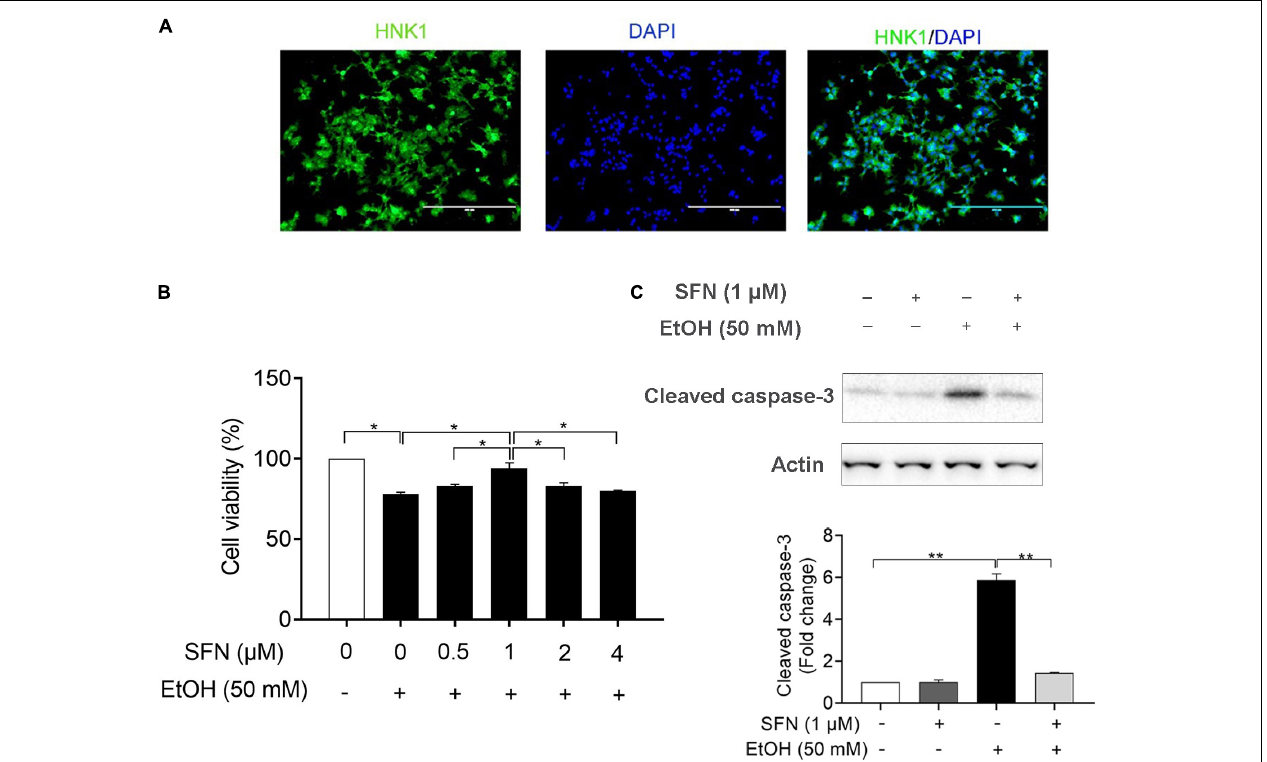
FIGURE 1 | SFN significantly diminished the ethanol-induced apoptosis in hNCCs. (A) Immunocytochemistry of NCC marker, HNK1, in hNCCs differentiated from hESCs. (B) hNCCs were treated with 50 mM ethanol alone or pretreated with SFN at different concentrations for 24 h, followed by concurrent exposure to SFN and ethanol for an additional 24 h. Cell viability was determined by MTS assay. (C) hNCCs were treated with 1 µ M SFN for 24 h, followed by concurrent exposure to 1 µ M SFN and 50 mM ethanol for an additional 24 h. Apoptosis was determined by the analysis of caspase-3 cleavage using Western blotting. Data are expressed as a percentage of control (B) or fold change over control (C) and represent the mean ± SEM of three separated experiments. * p < 0.05, ** p < 0.01.